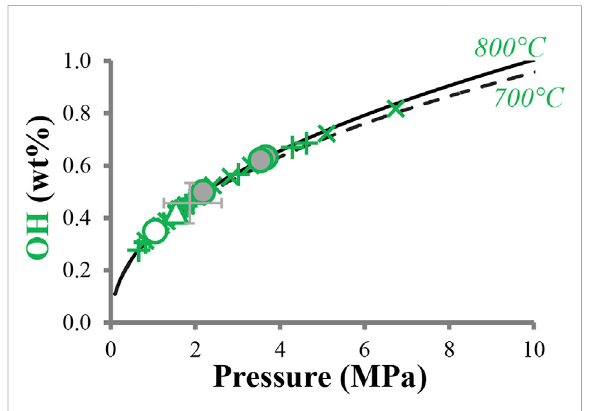
FIGURE 8 FTIR OH data as equivalent quench pressure. Mean OH wt% of all analyzed grains and clasts plotted against equivalent quench pressure assuming equilibrium H 2 O speciation at 800 ° C – 700 ° C. Equivalent quench pressures calculated using the H 2 O solubility model of Newman and Lowenstern (2002) for rhyolite at 800 ° C and H 2 O speciation model of Nowak and Behrens (2001)). Error bars show representative errors calculated for a grain with